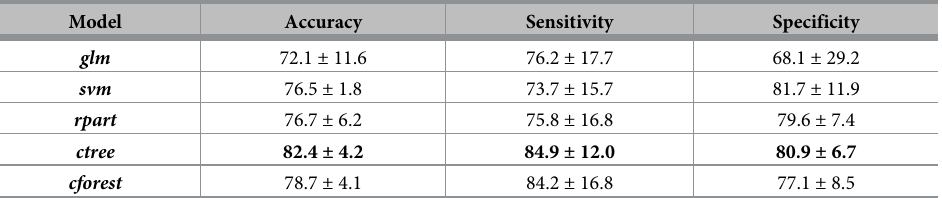
Table 1. Predictive model performance (mean ± sd).